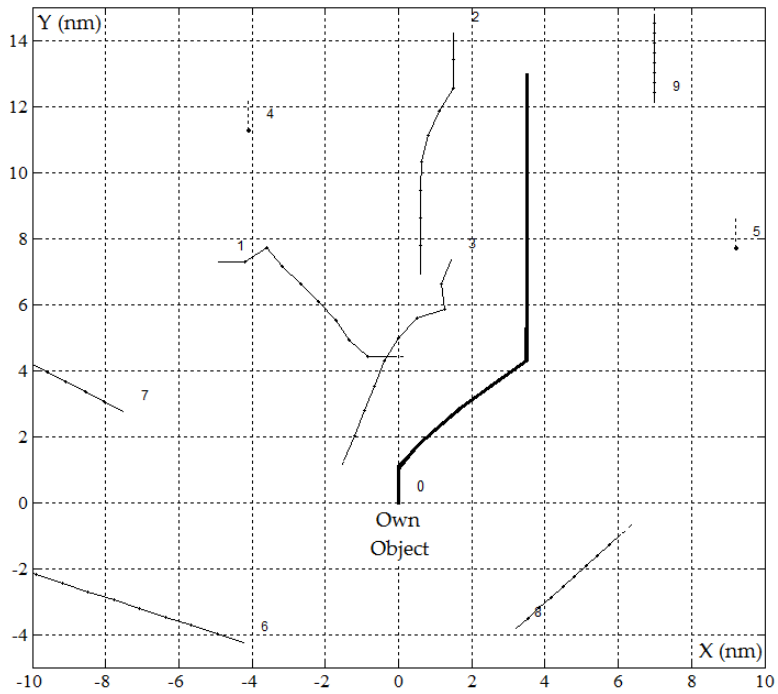
Figure 7. The safe trajectory of the own object for positional game PG_rv algorithm in restricted visibility at sea where D s = 1.5 nm in the situation of passing J = 9 encountered objects, r ( tK ) = 0 and d ( tK ) = 3.47 nm.